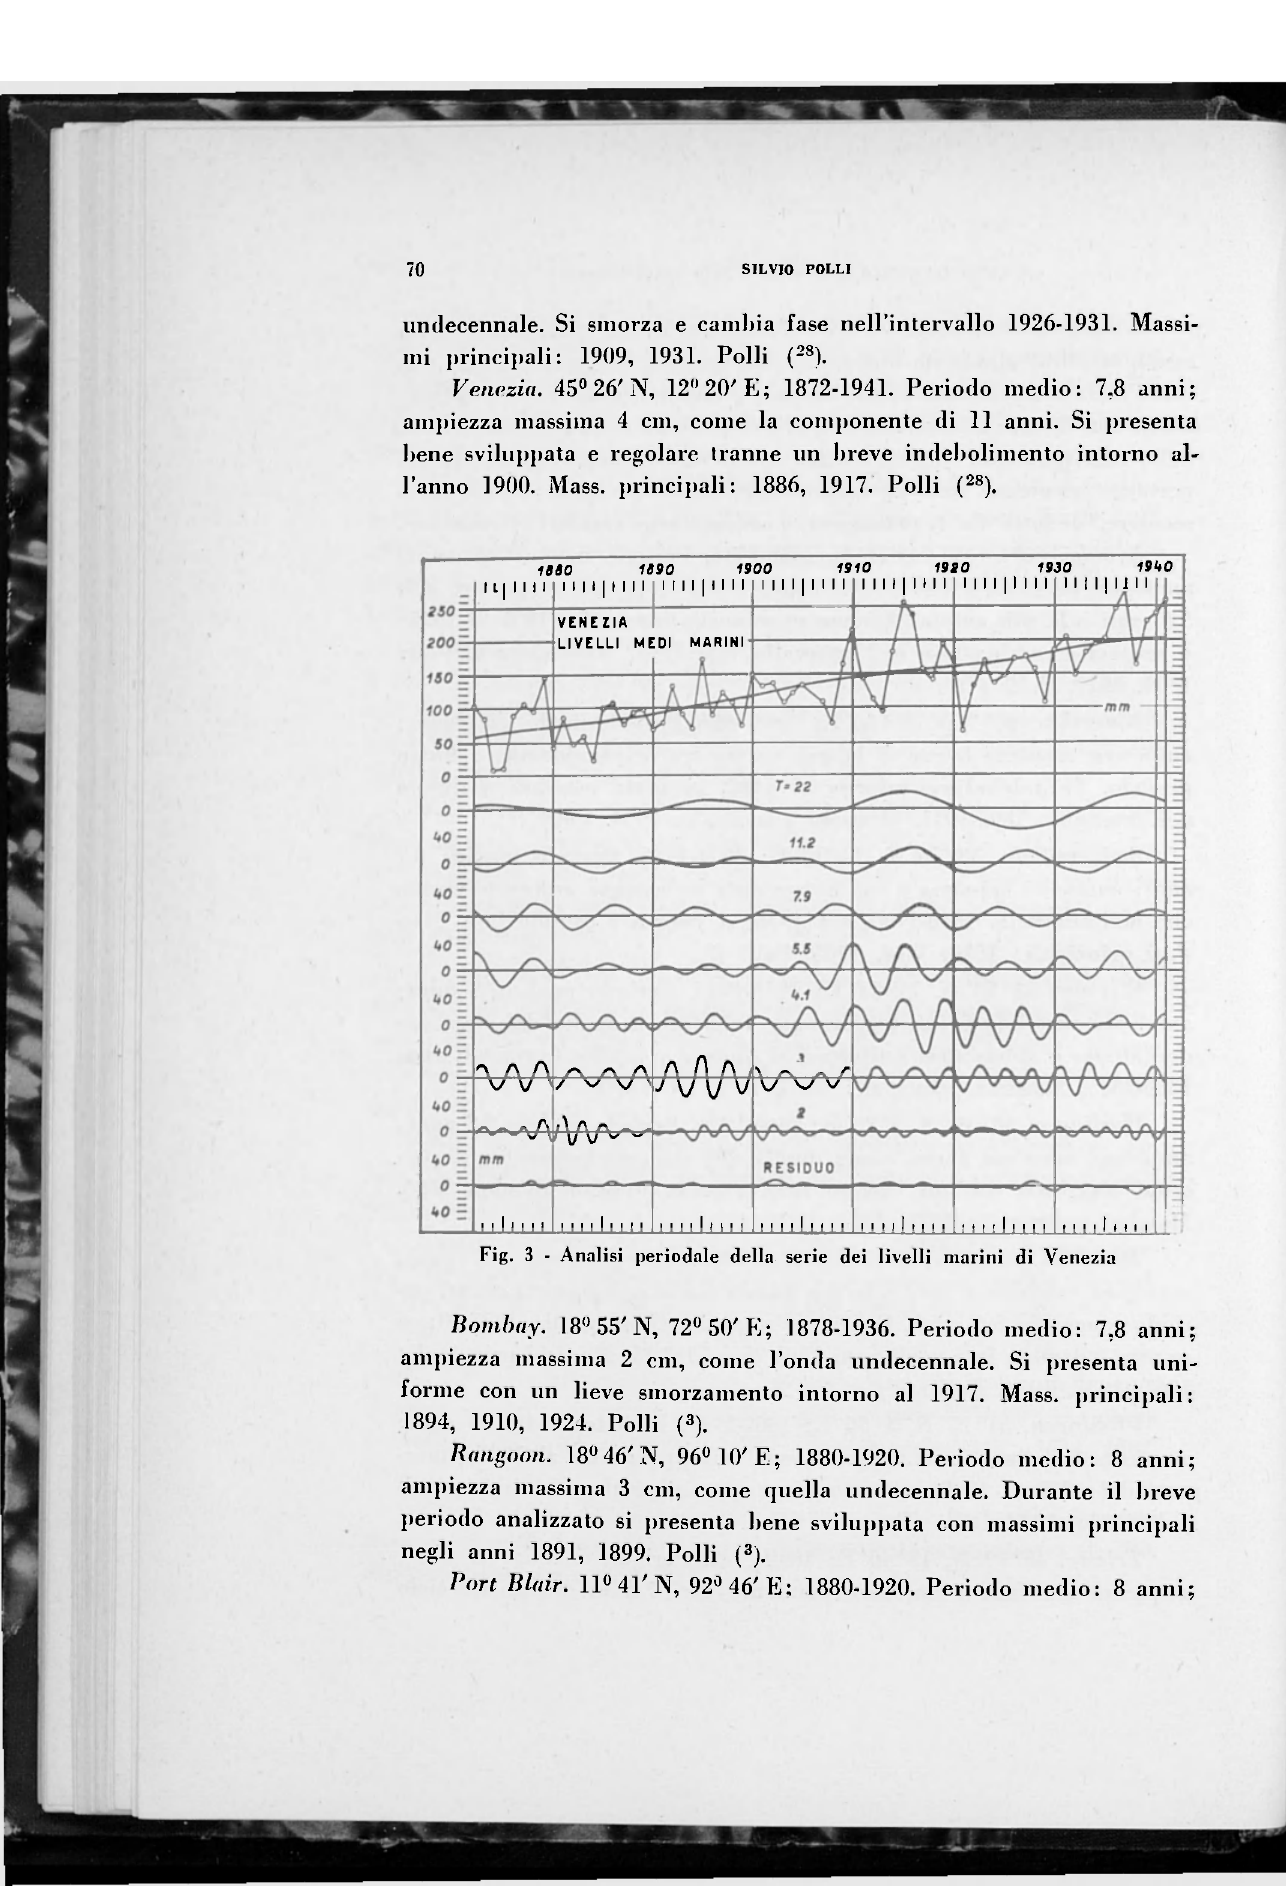
Fig. 3 - Analisi periodale della serie dei livelli marini di Venezia